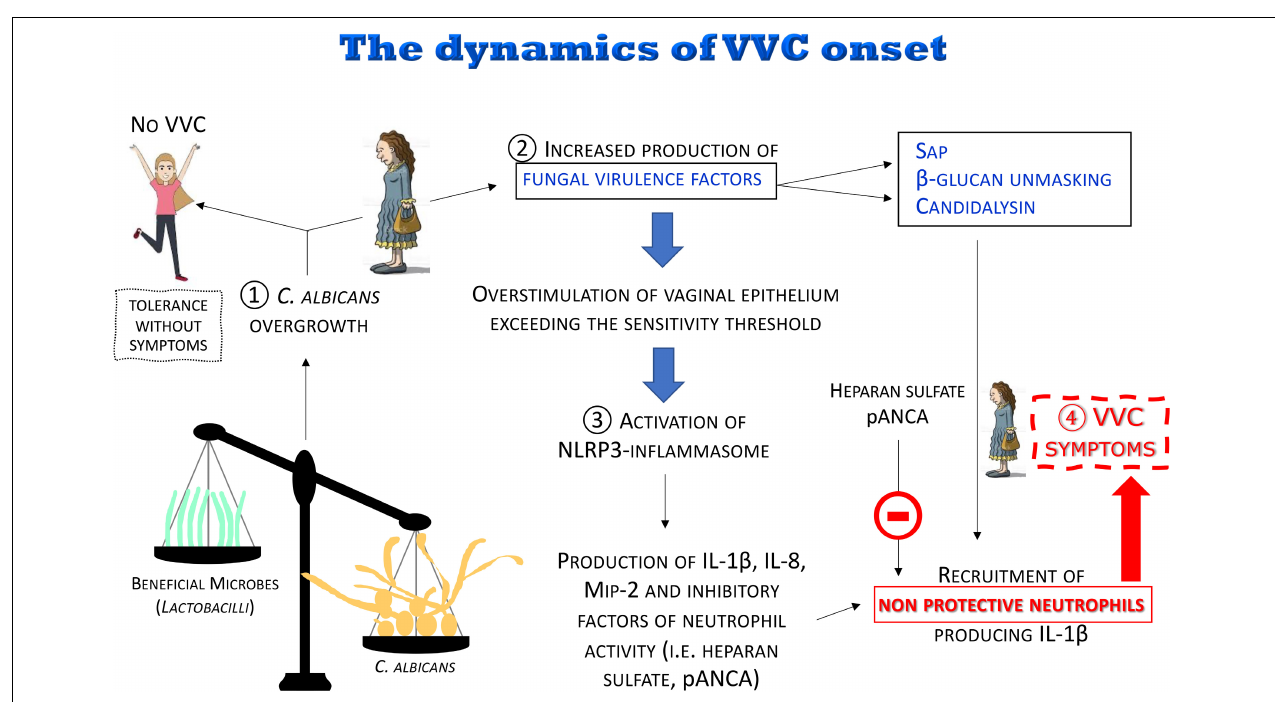
FIGURE 8 | The dynamics of the VVC onset. The disruption of the vaginal microbiota may lead to C. albicans overgrowth with increased production of fungal virulence factors. For most women, C. albicans colonization is tolerated without symptoms. When the overstimulation of the epithelium exceeds the sensitivity threshold, a local intense inflammatory response is induced. Pro-inflammatory cytokines and chemokines locally produced and some fungal virulence factors (i.e., Sap, candidalysin), as well as β -glucan unmasking, induce a massive recruitment of neutrophils whose anti-fungal activity is dampened by inhibitors (i.e., heparan sulfate and pANCA) present in the vaginal environment, consequently causing the symptoms of